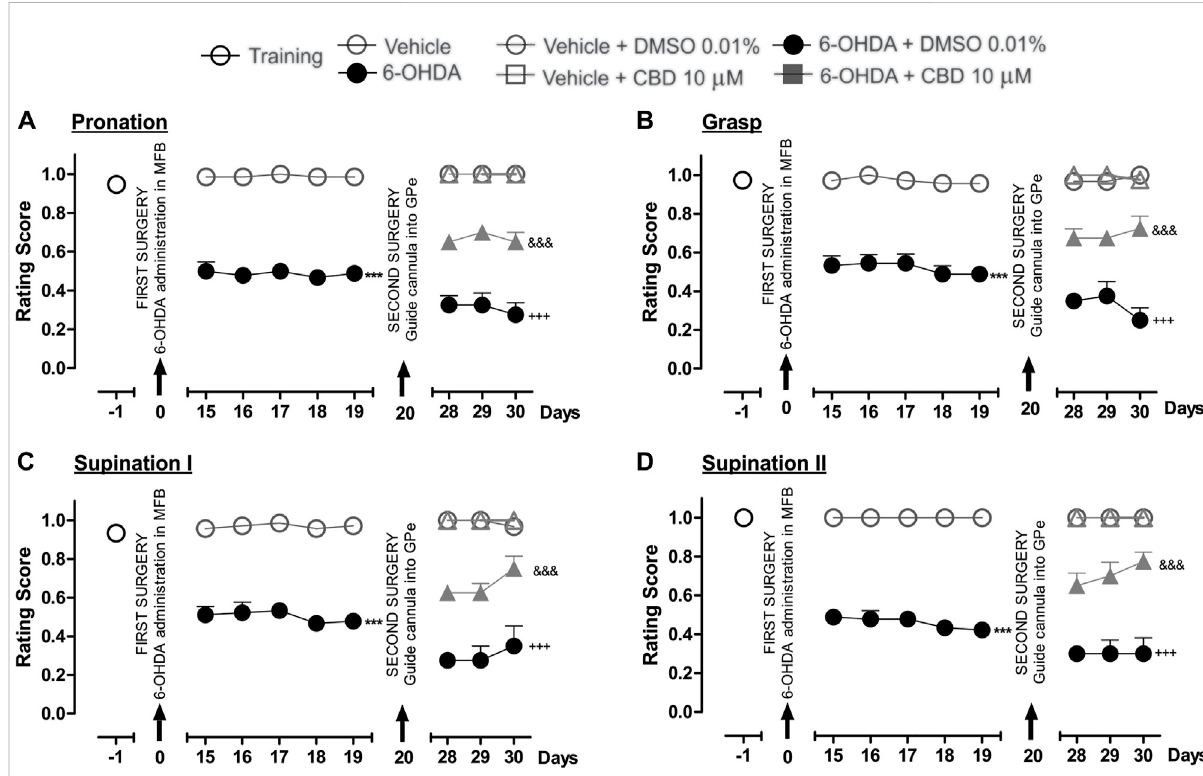
The administration of CBD in the GPe generated superior fi ne motor skills performance in the hemiparkinsonian rats analyzed in the staircase test. The four movement components selected to evaluate the contralateral forelimb performance for fi ne motor skills were as follows: (A) Pronation; (B) Grasp; (C) Supination I; and, (D) Supination II. The effect of the intrapallidal administration of CBD (10 µM) on the movement components were evaluated one day prior to the fi rst stereotaxic surgery (from the 15th to the 19th days post-lesion) and from the 28th to the 30th days post-lesion. It is shown that 6-OHDA + CBD group performed better in terms of fi ne motor skills than the 6-OHDA + DMSO group. Data are represented as the mean ± SEM of the fi ne motors skills scores obtained. *** p < 0.001 vs . vehicle; +++ p < 0.001 vs . vehicle + DMSO 0.01%; &&& p